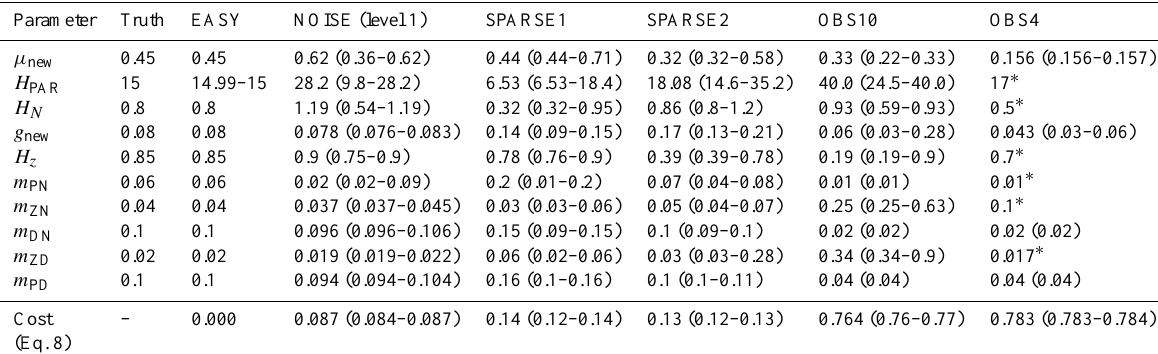
Table 3. Genuine truth parameter set (column 2) and estimates (column 3–8) obtained by the parameter retrieval experiments described in Table 2. The values in column 3 to 8 correspond to the first ensemble member of each retrieval experiment. In brackets we list the range enveloped by all ensemble